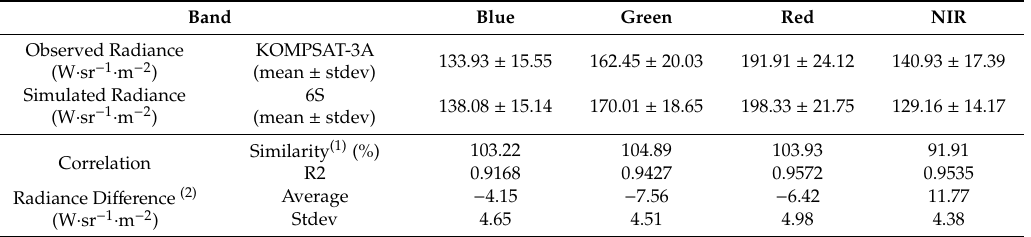
Figure 6. Measured by KOMPSAT-3A (K3A) and simulated by 6S over the Libya-4 PICS TOA radiance (X: front, Y: rear).